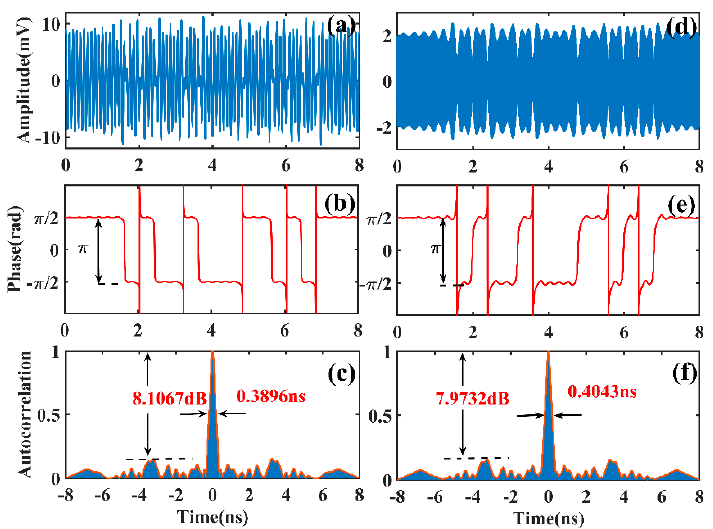
Figure 5. The waveforms and recovered phase information of signals, and respective autocorrela- tion (( a – c ), 10 GHz; ( d – f ), 80